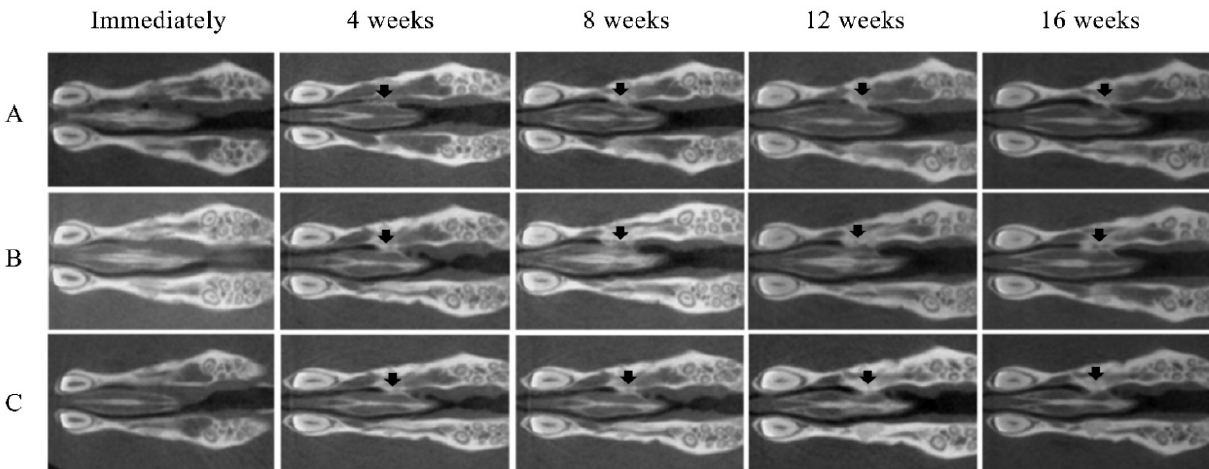
Figure 3. Micro-CT images of the maxilla immediately after grafting and at 4, 8, 12 and 16 weeks after grafting. New bone formation (arrows) at the margins of the left palatine process of the maxilla was noted on the radiographs of all samples. ( A ) Group 1 (low cross-linked RCP particles). ( B ) Group 2 (medium cross-linked RCP particles). ( C ) Group 3 (High cross-linked RCP particles). Each image shows the horizontal plane section of the maxilla in the